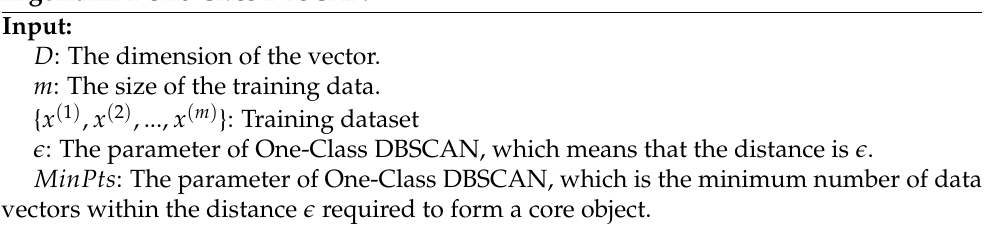
Algorithm 1 One-Class